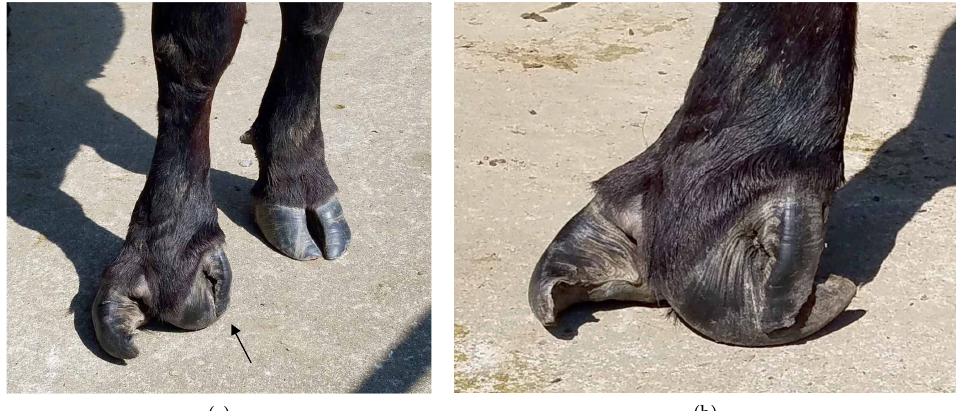
Figure 1: Front feet of Dexter cow Case 1 at 38 mo of age. (a) Dorsal view of feet. (b) Lateral view of right foot. The left foot appeared normal. The right foot displayed polydactyly based on a third digit alongside and detached from the abaxial wall of the medial digit. Arrow indicates the extra digit. The dew claw ipsilateral to the extra digit was absent.